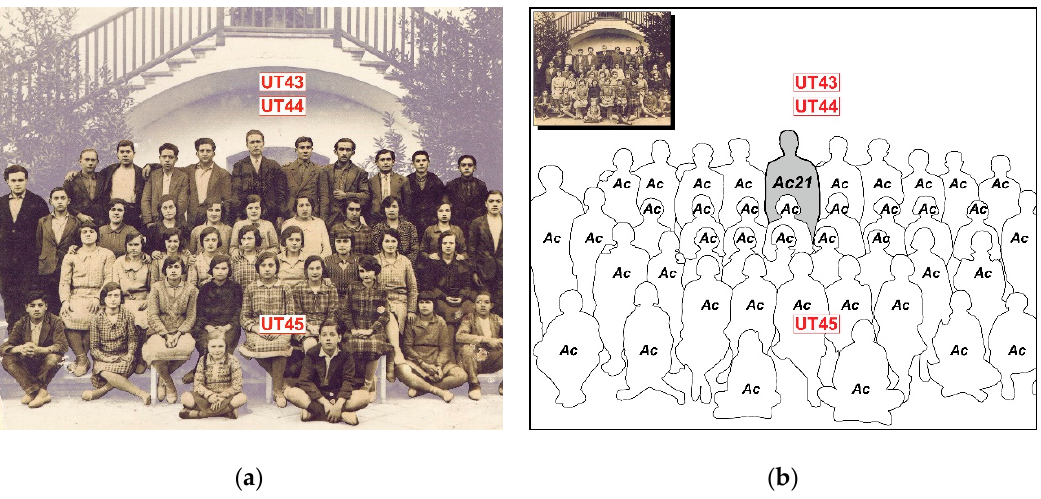
Figure A4. Schoolchildren from the Company Guarro Casas’ School, taken in Gelida (Catalonia, Spain) in 1927. UT are labeled directly onto the picture ( a ) while Ac are labeled in a separate sketch for the sake of clarity ( b ). We edited the original picture by means of image processing and illustration software.